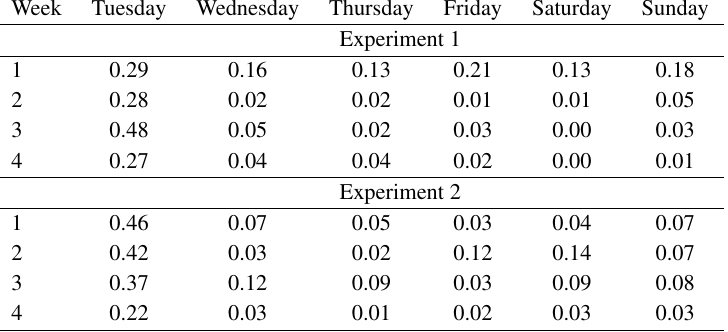
Table 2: Jansen-Shannon Divergence of end-of-day market price distributions in Experiments 1 and 2.